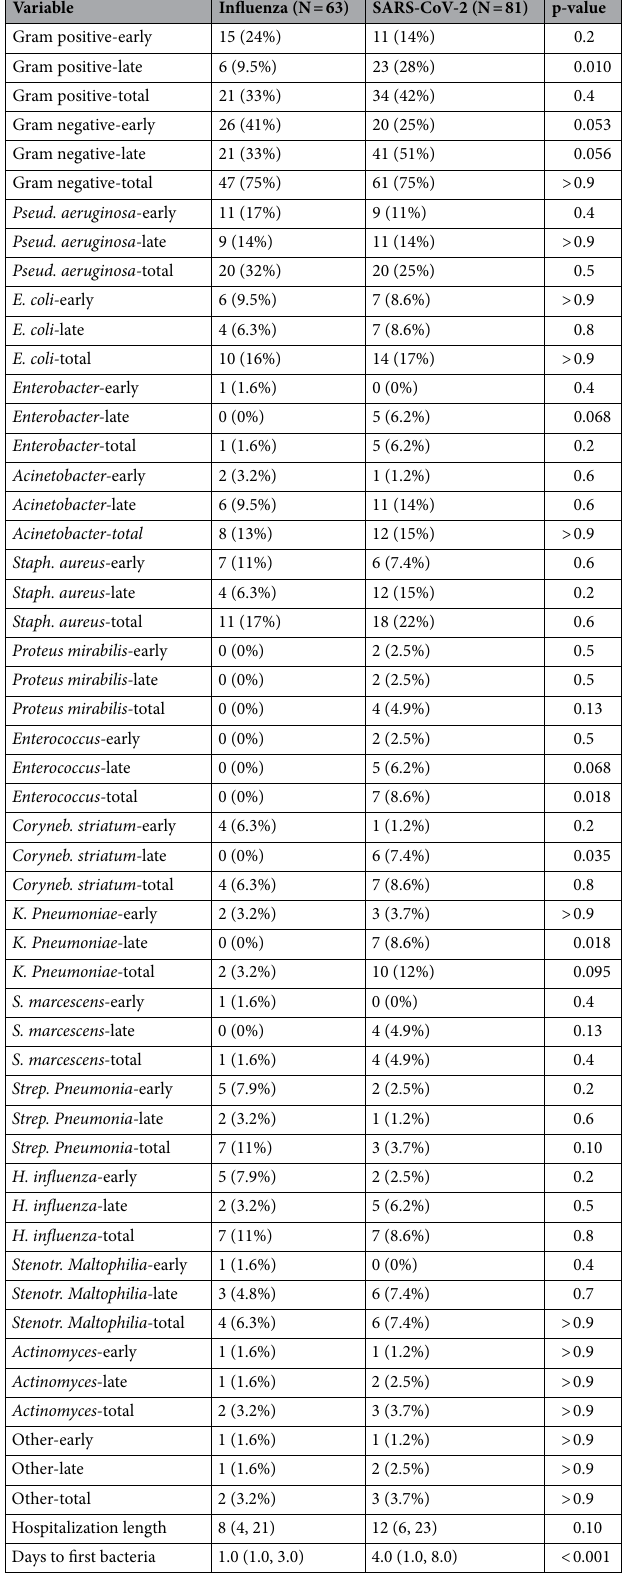
Table 2. Main documented bacterial coinfections according to the type of viral